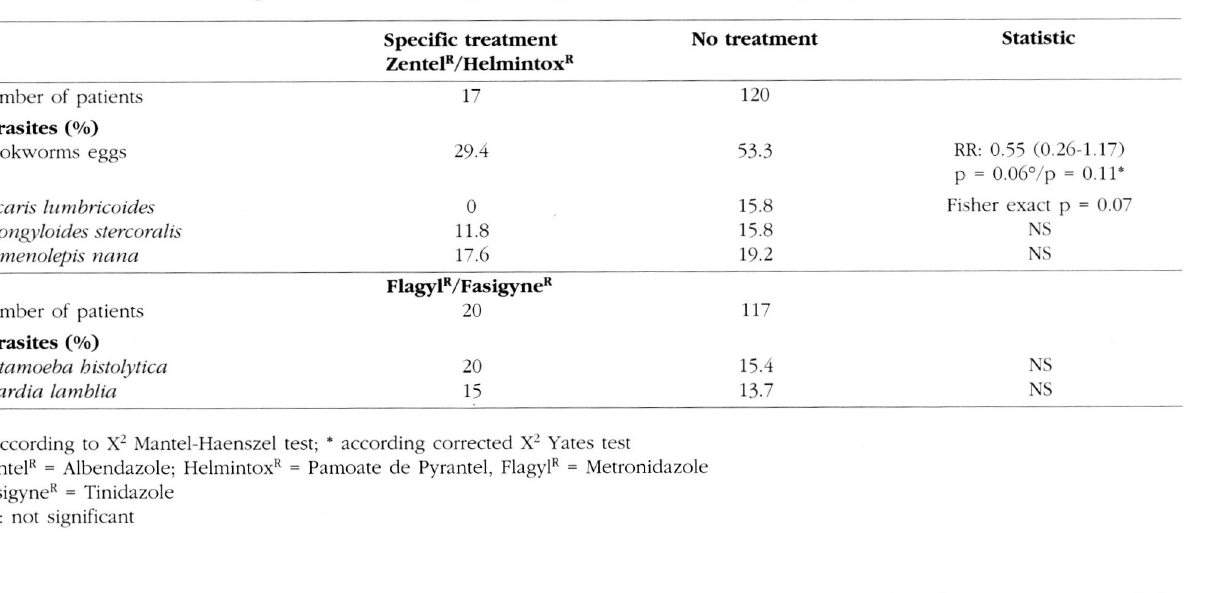
Table IV. - Prevalence according to whether or not antiparasitic agents had been taken during the previous six